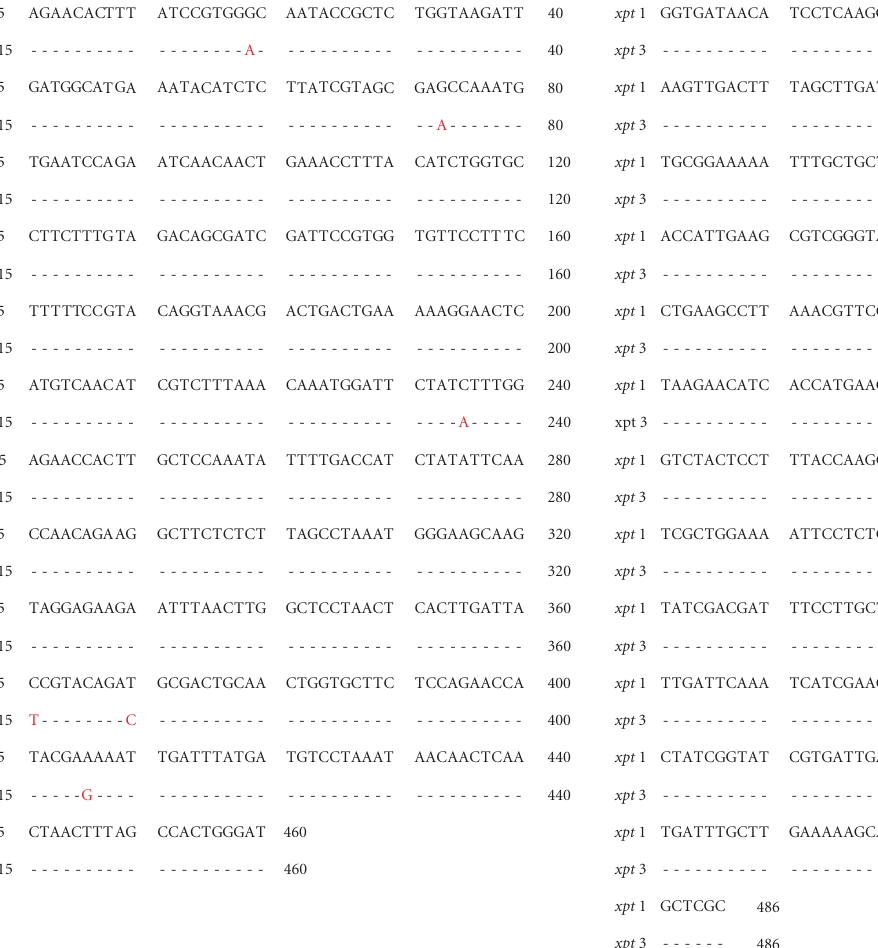
with asymptomatic carriage [24]. Due to the limited data, the odds ratio of the newly identified ST-1989 is